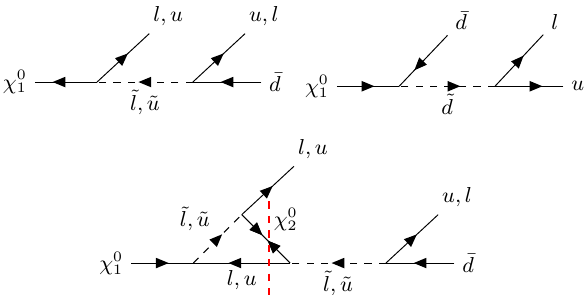
Fig. 1 The tree level and next higher order diagrams giving rise to leptonic asymmetry. Lepton number violating coupling is on the right of the vertical ‘cut’ shown in second diagram 1